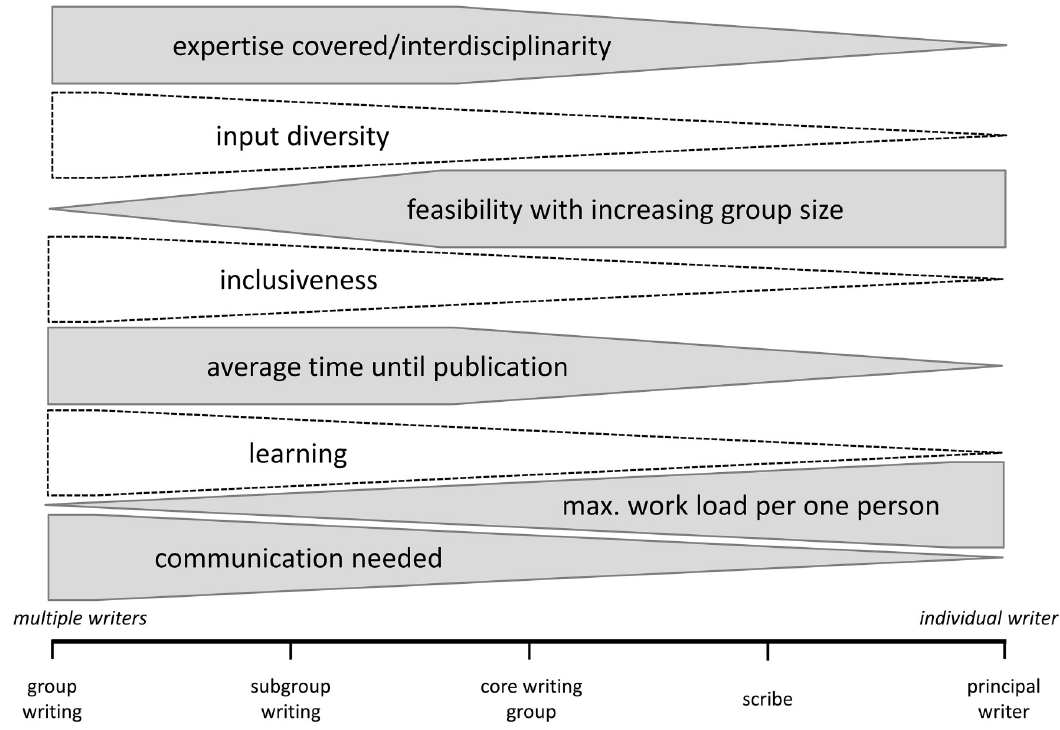
Fig 1. Decision chart for writing strategy. Different writing strategies ranging from very inclusive to minimally inclusive: group writing = everyone writes on everything; subgroup writing = document is split up into expertise areas, each individual contributes to a subsection; core writing group = a subgroup of a few coauthors writes the paper; scribe writing = one person writes based on previous group discussions; principal writer = one person drafts and writes the paper (writing styles adapted from [20]). Which writing strategy you choose depends on external factors (filled, gray shapes), such as the interdisciplinarity of the study or the time pressure of the paper to be published, and affects the payback (dashed, white shapes). An increasing height of the shape indicates an increasing quantity of the decision criteria, such as the interdisciplinarity, diversity, feasibility, etc.